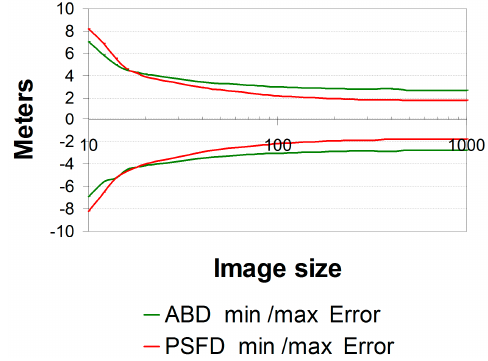
Figure 8. Behavior of the error as a function of the image size (in pixels) used for CC. Both the upsampling factor and image size parameters have been tested independently.